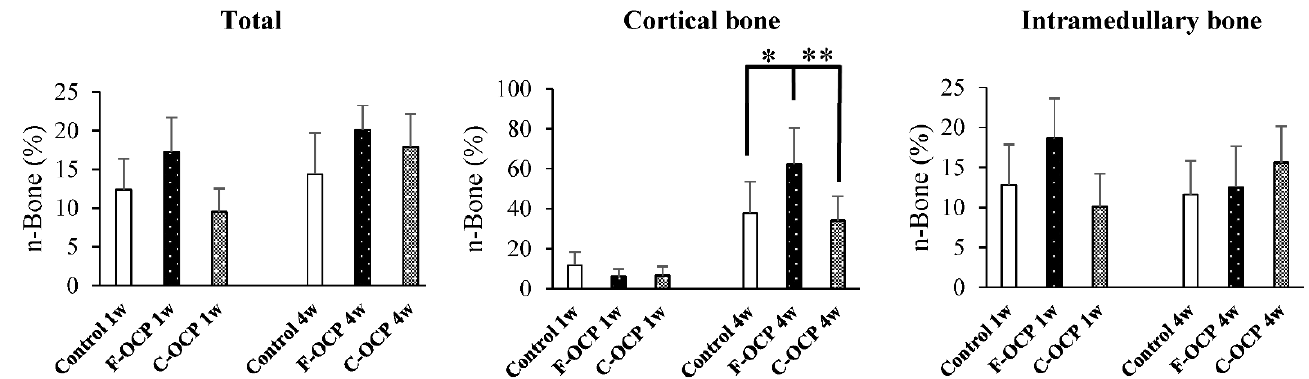
Figure 9. Histomorphometric analysis of newly formed bone area of total, cortical, and intramedullary bone treated with no materials (control), F-OCP, and C-OCP at 1 week and 4 weeks post-implantation (** p < 0.01, * p < 0.05).